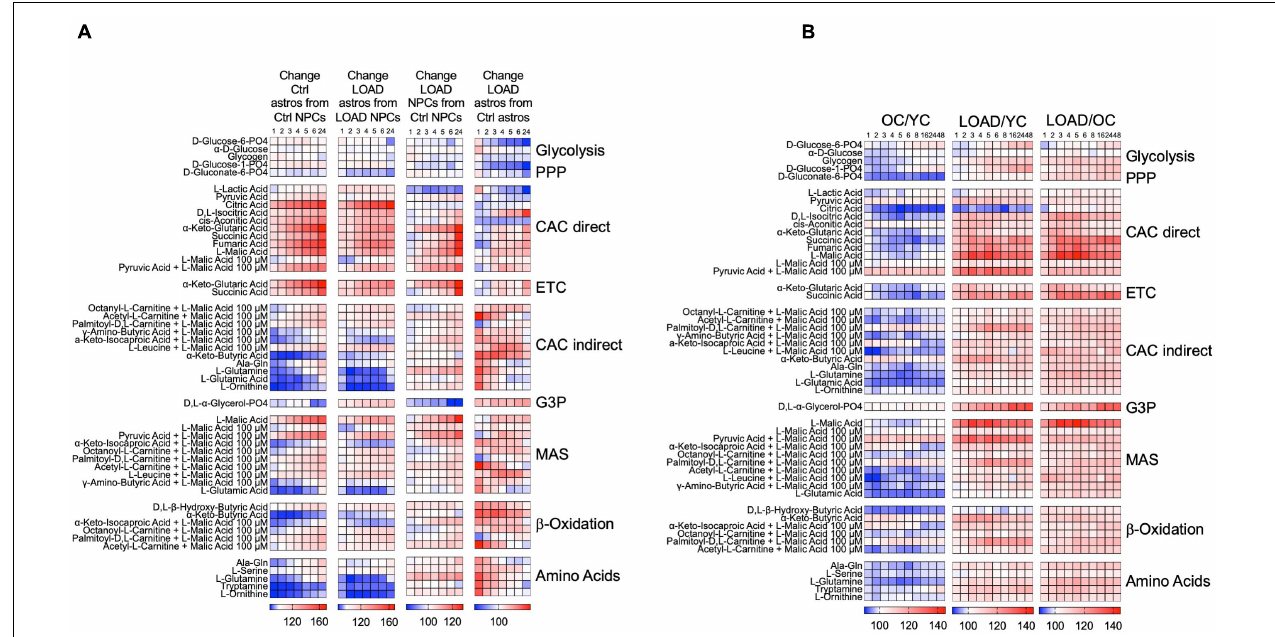
FIGURE 6 | Processing of bioenergetic substrates in iPSC-derived NPCs and astrocytes, and fibroblasts. (A,B) Data from Biolog MitoPlate S-1 assays on LOAD ( n = 9) and Control ( n = 9) NPCs and astrocytes (A) , and YC ( n = 7, average age 30.1 ± 8.6), OC ( n = 7, average age 68.4 ± 10.8), and LOAD ( n = 9, average age 70.9 ± 7.4) fibroblasts (B) . Processing of 31 substrates were kinetically measured at 1, 2, 3, 4, 5, 6, 8, 16, 24, and 48 h, and data plotted as heat maps showing percent changes in astrocytes from NPCs reflecting changes in cell development, LOAD from Control cells reflecting disease-associated alterations, and OC from YC reflecting age. The data are from duplicate experiments and clustered according to bioenergetic functions as explained in the